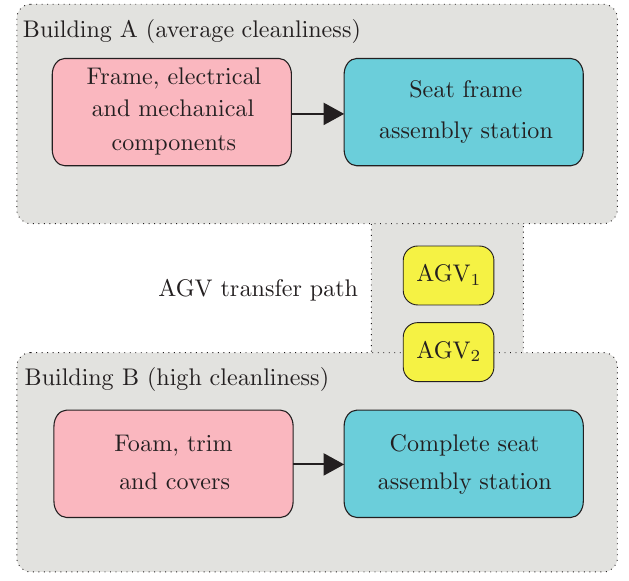
Figure 5. Seats assembling system.